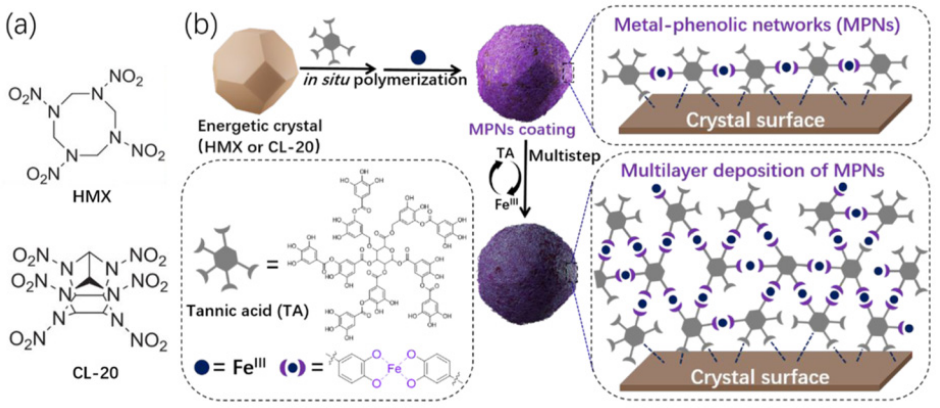
Figure 12. ( a ) Molecular structures of the typical energetic molecules HMX and CL-20; ( b ) Schematic representation of the preparation of the surface-modified energetic crystal via multilayer deposition of MPNs. Reproduced with permission from [65], copyright 2020, Elsevier.